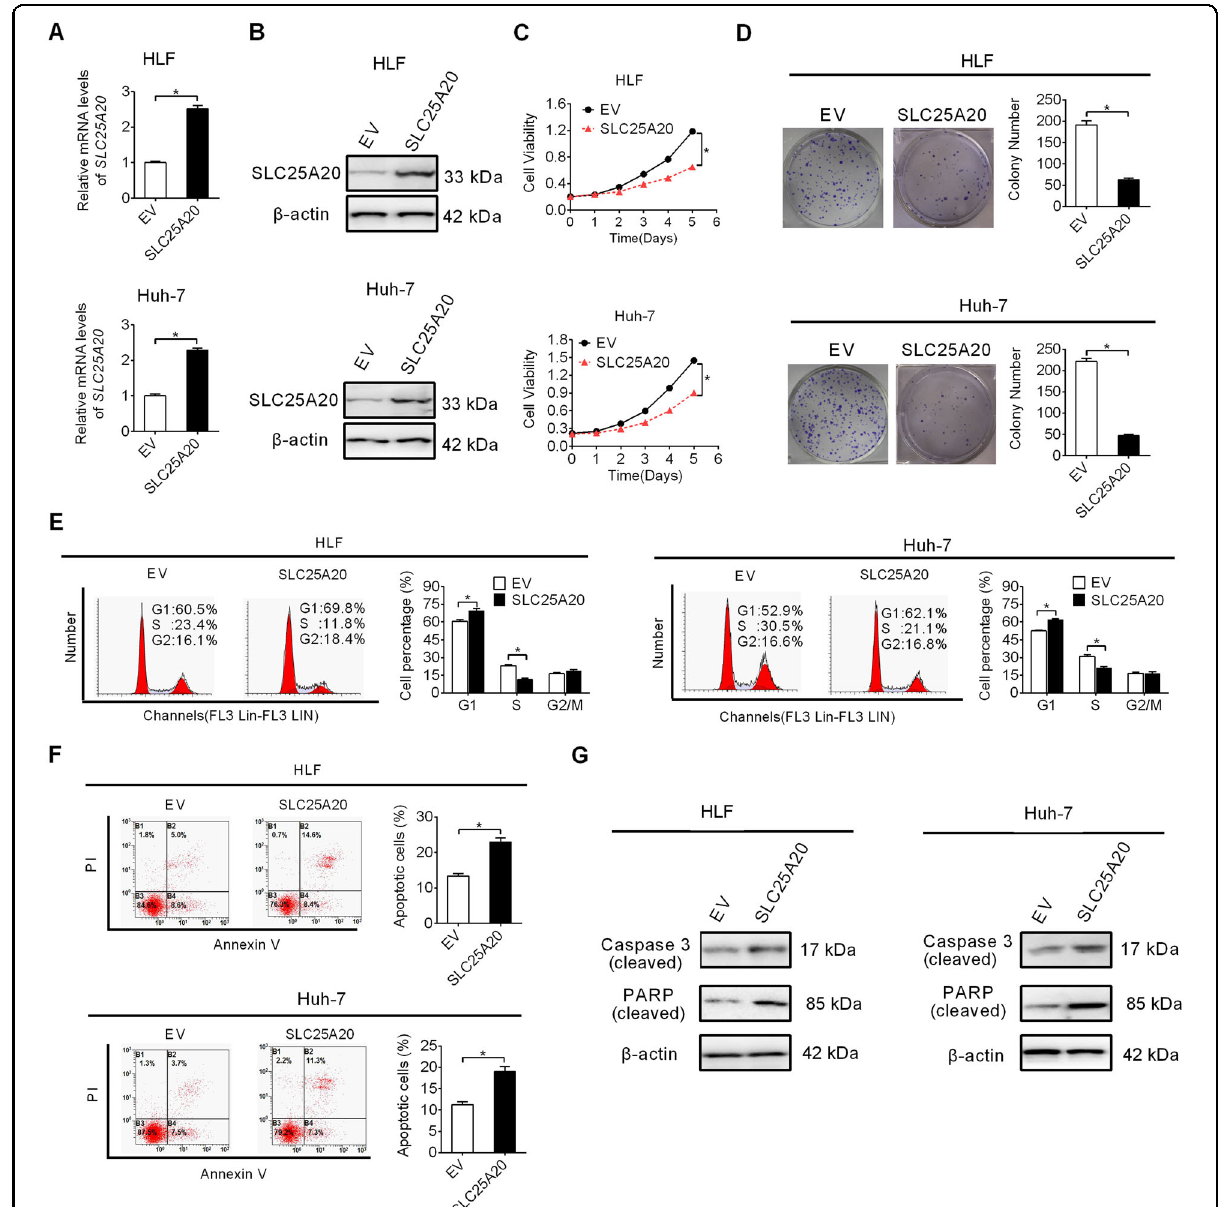
Fig. 2 Forced expression of SLC25A20 suppressed HCC growth by inducing G1 – S cell-cycle arrest and cell apoptosis. A , B SLC25A20 overexpression was con fi rmed by qRT – PCR and Western blot analysis in HLF and Huh-7 cells with treatment as indicated. (SLC25A20, expression vector encoding SLC25A20; EV, empty vector). C , D Cell growth was determined by MTS cell viability and colony formation assays in HLF and Huh-7 cells with treatment as indicated. E , F Cell cycle distribution and cell apoptosis were determined by fl ow cytometry analysis in HLF and Huh-7 cells with treatment as indicated. G Western blot analysis for levels of cleaved caspase-3 and cleaved PARP in HLF and Huh-7 cells with treatment as